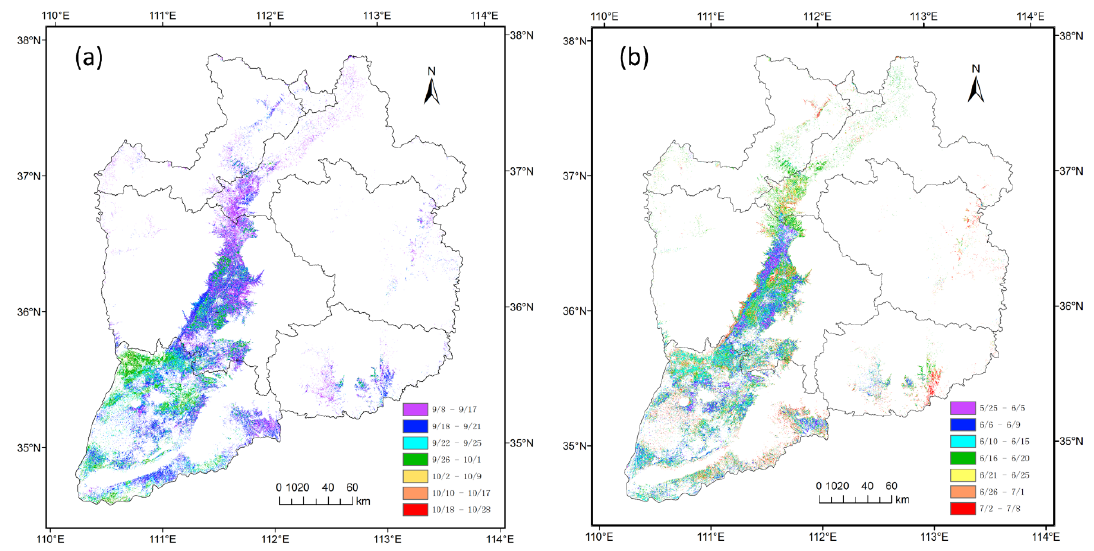
Figure 4. Spatial patterns of wheat sowing ( a ) and maturity ( b ) dates in south central Shanxi Province.